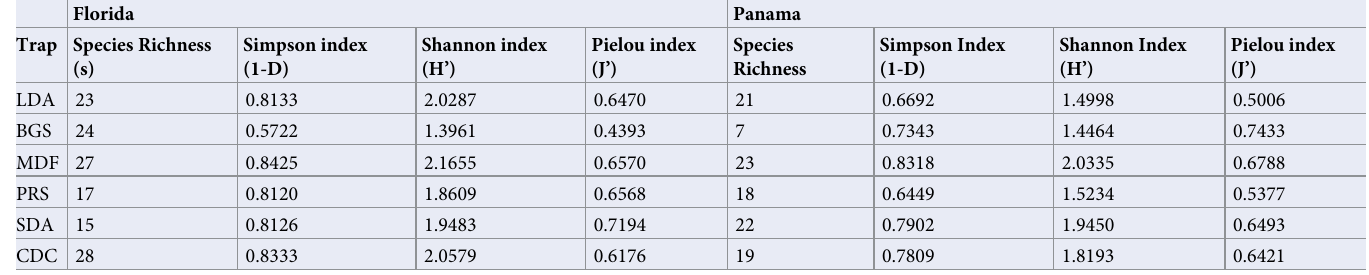
Table 3. Values for species richness, Simpson index, Shannon index, and Pielou’s index for the large diameter aspirator (LDA), BG-Sentinel (BGS), CDC miniature light trap (CDC), mosquito drift fence (MDF), pop-up resting shelter (PRS), and the small diameter aspirator (SDA) in Florida and